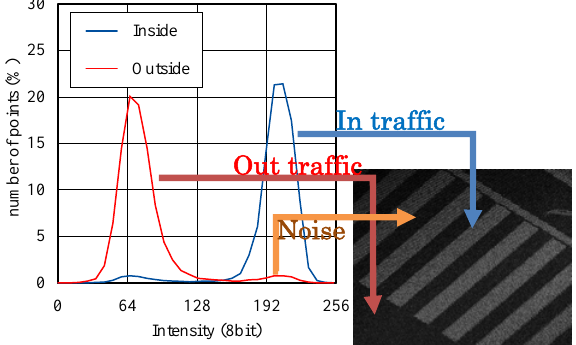
Figure 7. Intensity distribution around traffic marking